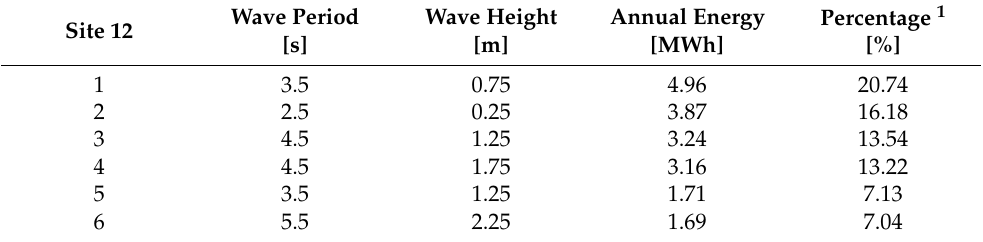
Table 4. Sea states (31 sea states in total) that contributed the most to total annual energy at Site 12. Site